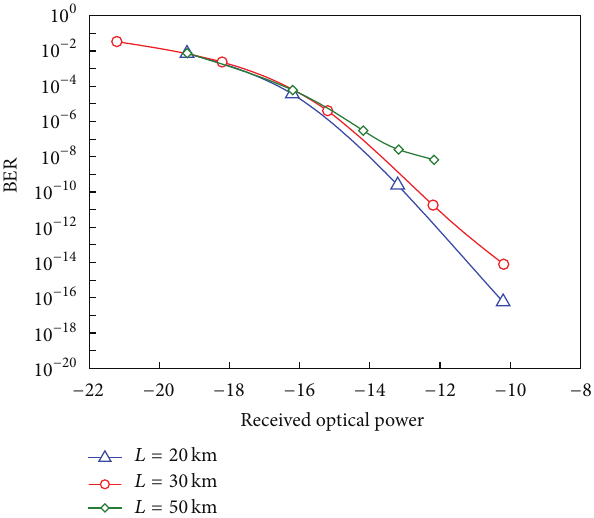
Figure 7: The system performance at different lengths of the optical fiber.